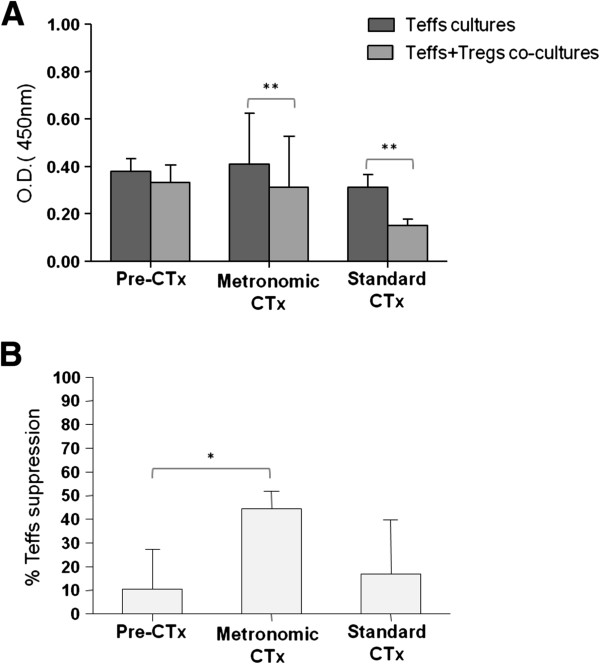
Metronomic chemotherapy affects the number and function of Tregs. (A) Teff proliferation was measured by the cell proliferation assay and expressed as mean optical densities (OD) at 450 nm ± SE. Teffs, single cultures of Teffs; Teffs + Tregs, co-cultures of Teffs with autologous Tregs at a ratio 4:1. (B) Treg-induced suppression of Teff proliferation. Shown are mean % values ± SE. Pre-CTx, patients before chemotherapy administration. All samples were analyzed in triplicates. * p < 0.05, ** p < 0.01, as estimated by paired-t test.